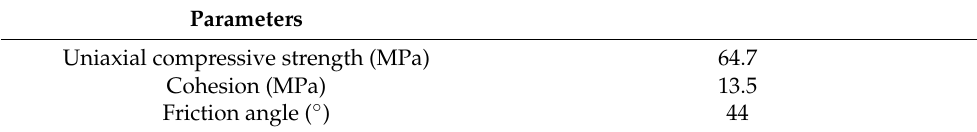
Table 2. Mechanical parameters of red